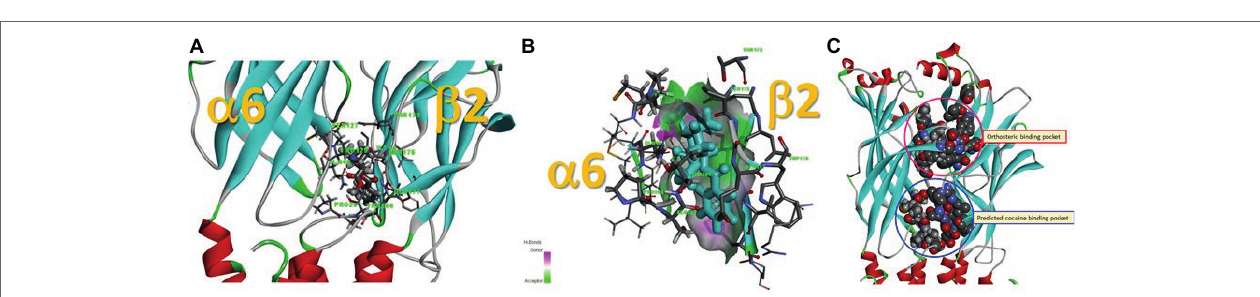
FIGURE 8 | Potential cocaine binding site in the α 6 M211L α 3 IC β 2 β 3-nAChR. (A) Cocaine docked to a potential binding pocket identified by the software in the subunit interface between α 6 M211L α 3 IC and β 2 subunits and in the coupling region between N-terminal domain and a transmembrane domain. (B) A closer look at the potential cocaine interactions with the receptor. (C) Comparison of the binding sites between nicotine (orthosteric binding pocket) and cocaine (predicted cocaine binding